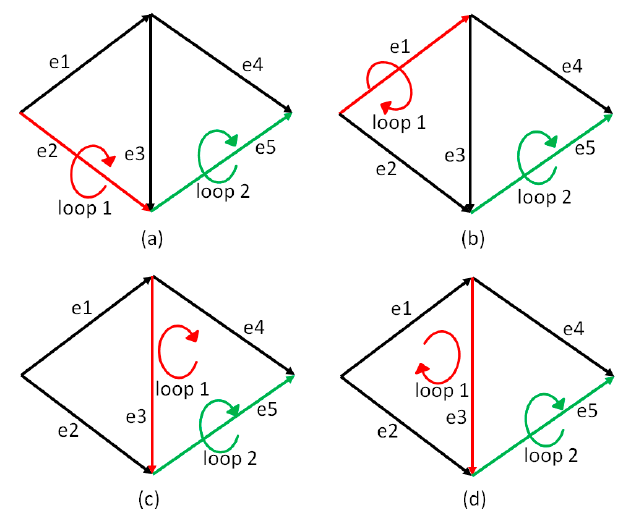
Figure 4. Division of the minimum closed loops based on different spanning trees (black edges) and the corresponding co-tree branches (red and green edges). ( a ) Loop one is e2-e3-e1 and loop two is e5-e4-e3; ( b ) loop one is e1-e2-e3 and loop two is e5-e4-e3; ( c ) loop one is e3-e5-e4 and loop two is e5-e4-e1; ( d ) loop one is e3-e2-e1 and loop two is e5-e4-e1.